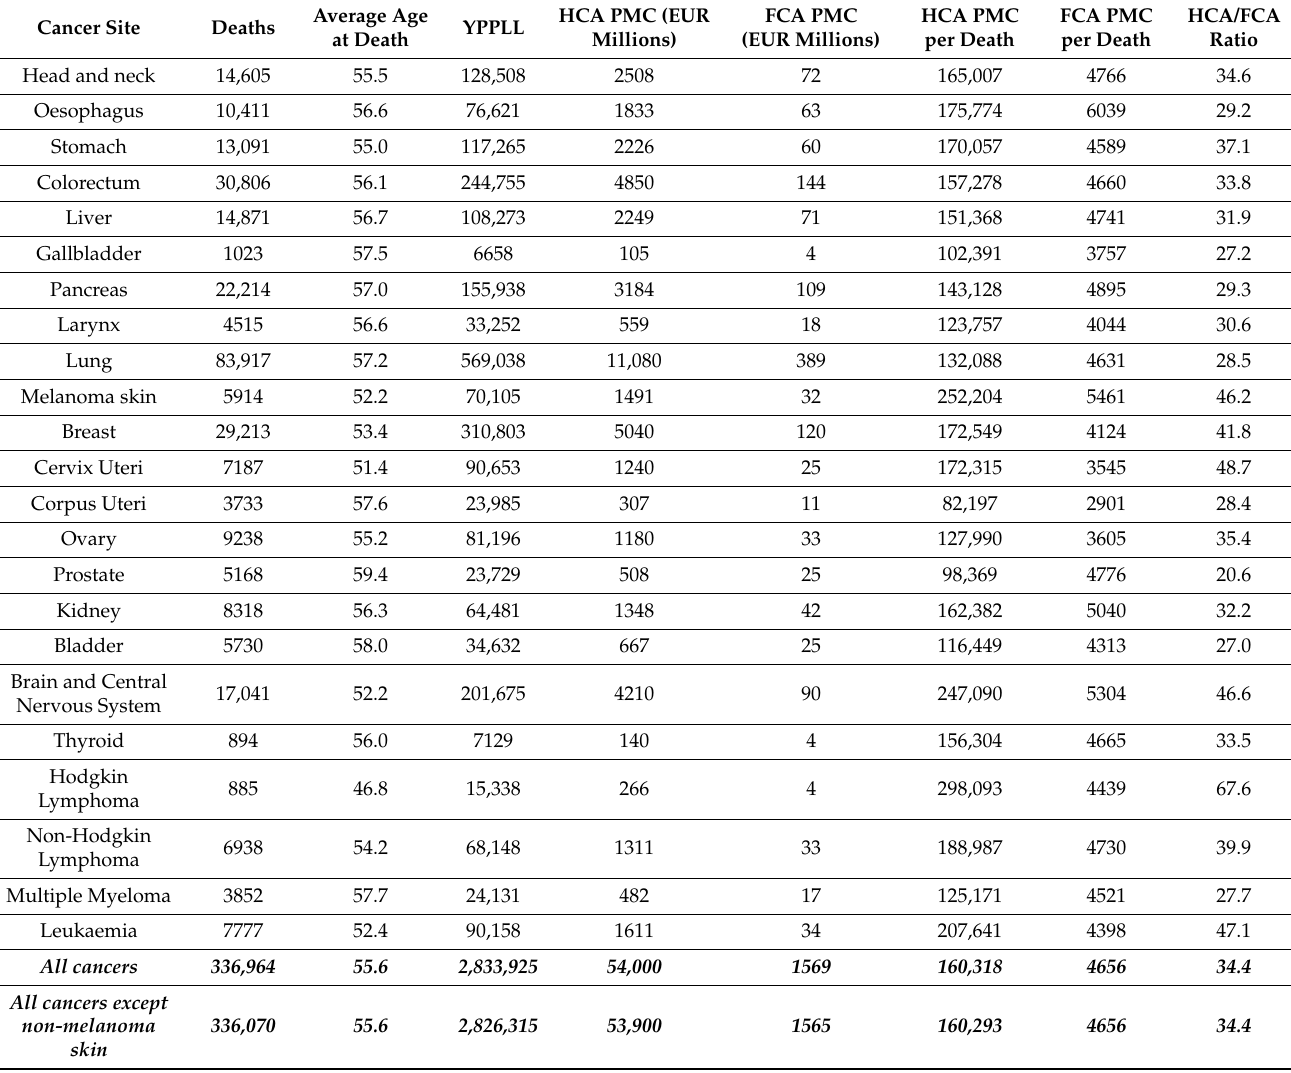
Table 3. Cancer-related premature mortality costs (PMC) (EUR, total and per cancer death) by Human Capital Approach (HCA) and Friction Cost Approach (FCA) for Europe by cancer site in